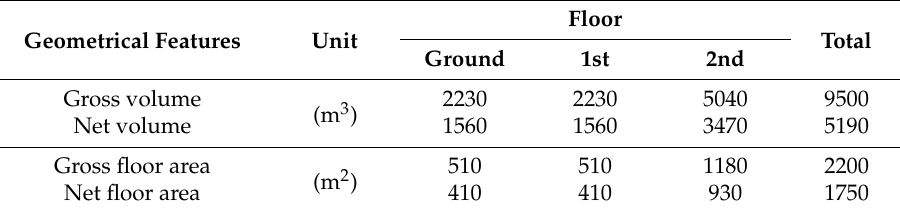
Table 1. Palazzo Medici: volumes and areas used as public offices for each